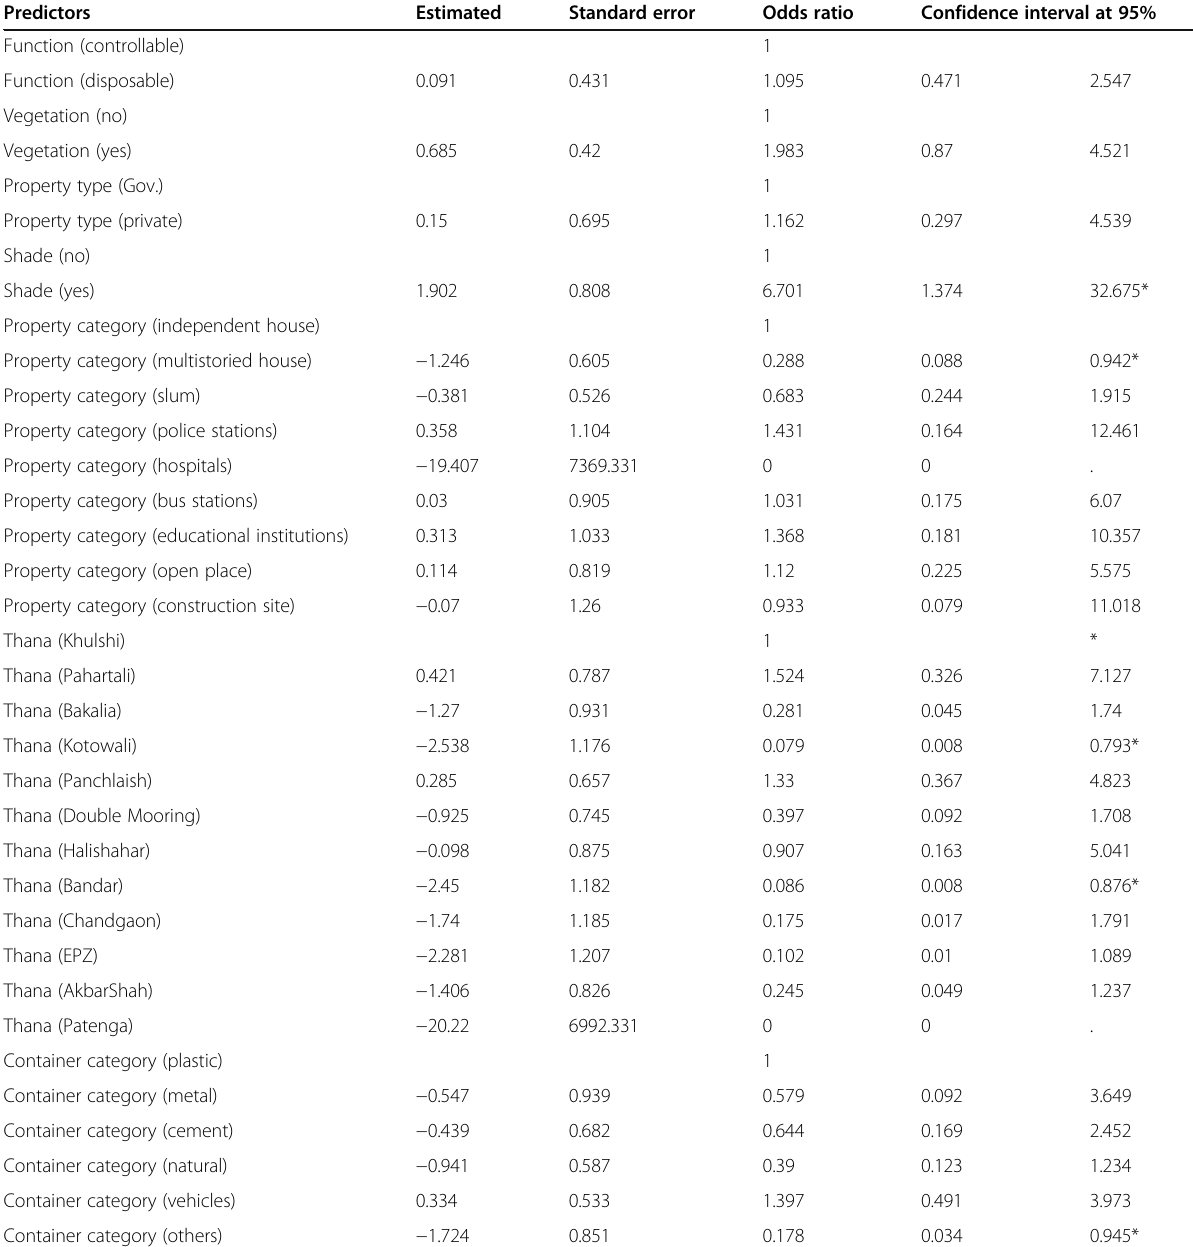
Table 5 Binary logistic regression to identify factors associated with the presence of Aedes sp. larvae and/or